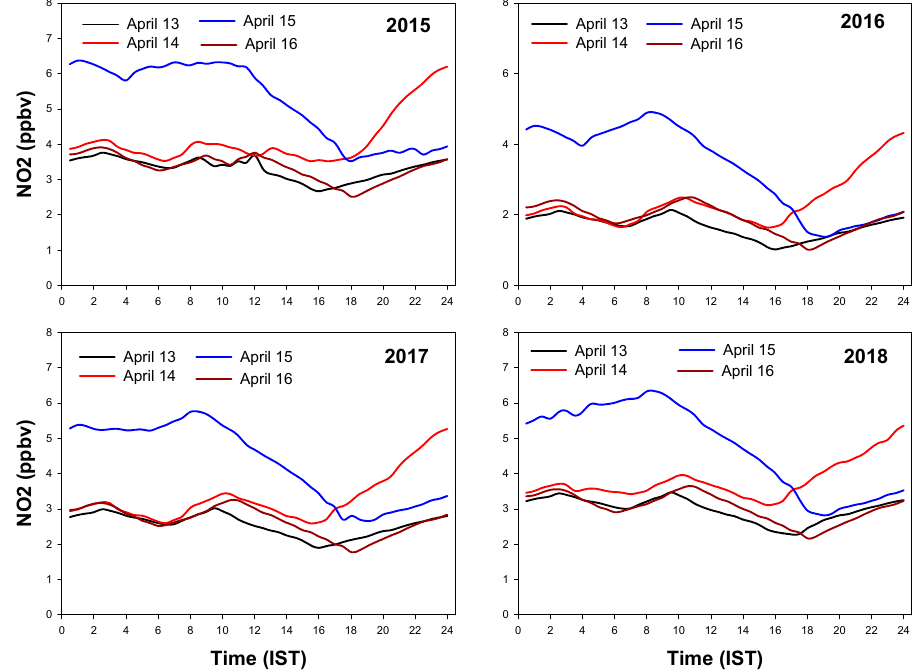
Figure 6. Diurnal variation of NO 2 at Kannur during pre-, post-, and Vishu days for four consecutive years of 2015, 2016, 2017, and 2018.